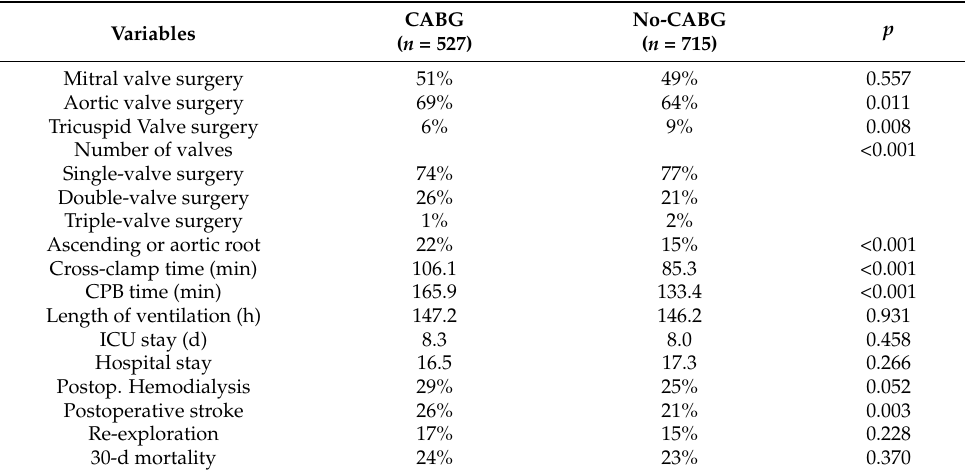
Table 4. Operative procedures in patients with coronary artery disease after adjustment using inverse probability